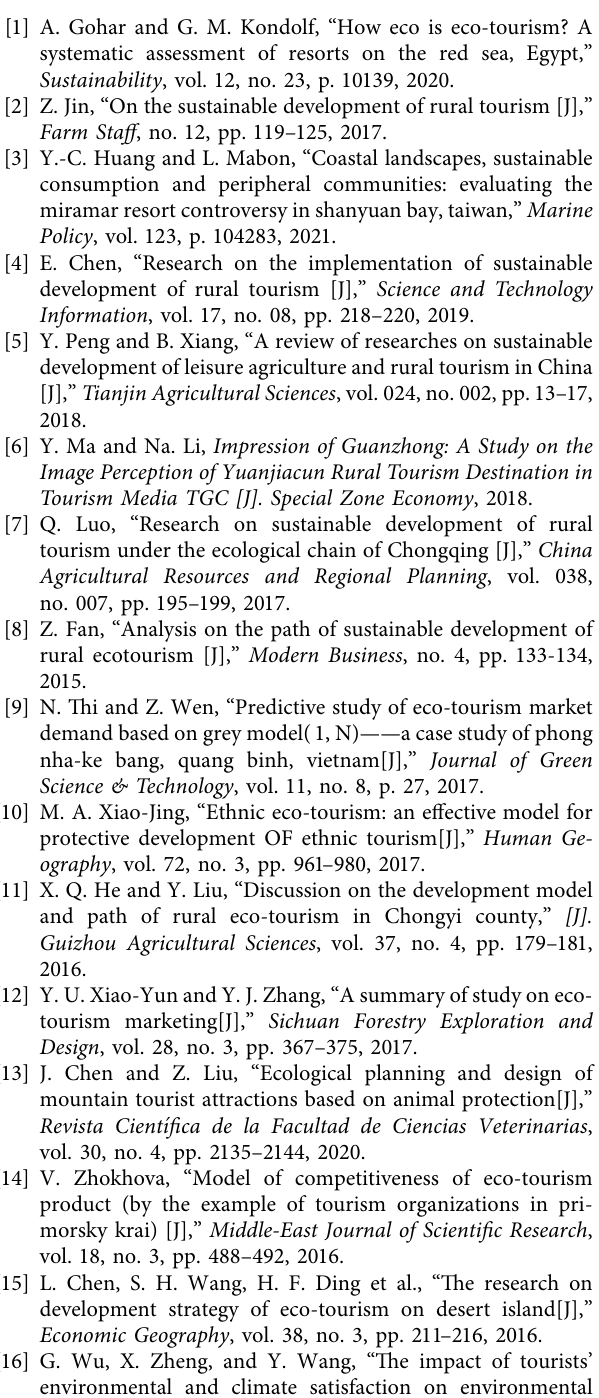
Table 4: The comparison between the number of